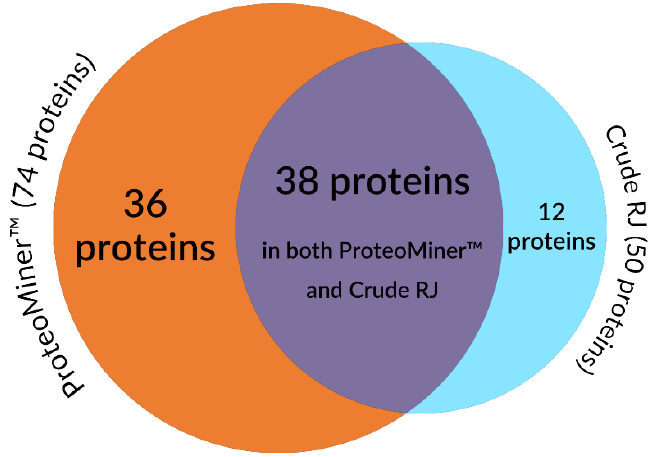
Figure 1. The number of proteins identified in unpurified samples, samples pre-treated with ProteoMiner TM , and both in unpurified and purified samples.